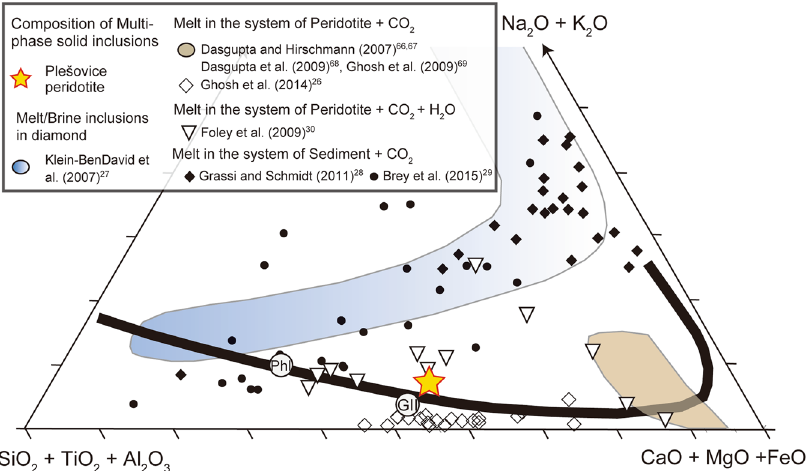
Figure 6. This panel shows a summary of carbonated silicate melts preserved as multiphase solid inclusions (MSIs) in the Plešovice peridotite in comparison with those produced by experiments 26–30,66–69 . Ternary (wt.%) diagram projected from CO 2 and H 2 O. The average compositions of group II kimberlites 25 (GII) and of phlogopite (Phl) are shown. The thick curve represents the solvus for a silicate–carbonatite liquid at 1100 °C and 3.7–5.0 GPa 28 . The mean value of carbonated melt reconstructed from MSIs in the Plešovice peridotite is represented as a yellow star which is close to the composition of GII